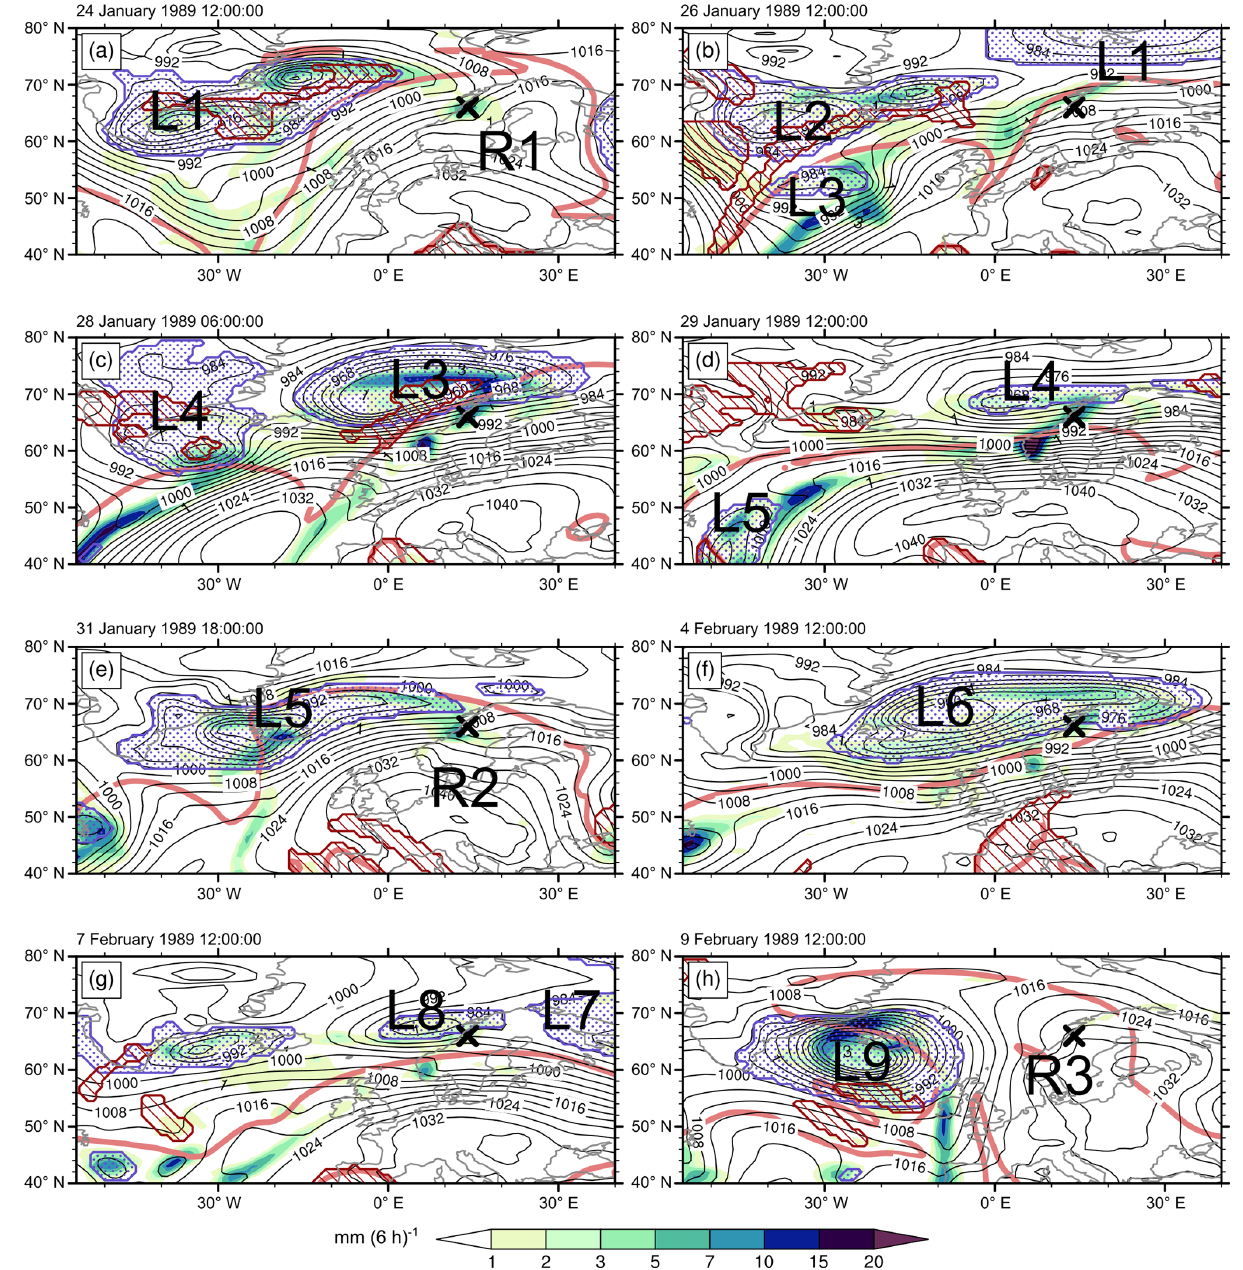
Figure 4. As Fig. 3 but for the longest wet spell at 66 ◦ N, 14 ◦ E in Norway ( S 1 (66 ◦ N, 14 ◦ E)). The light red lines depict 2PVU at 310K. The valid time of each panel is shown in the top